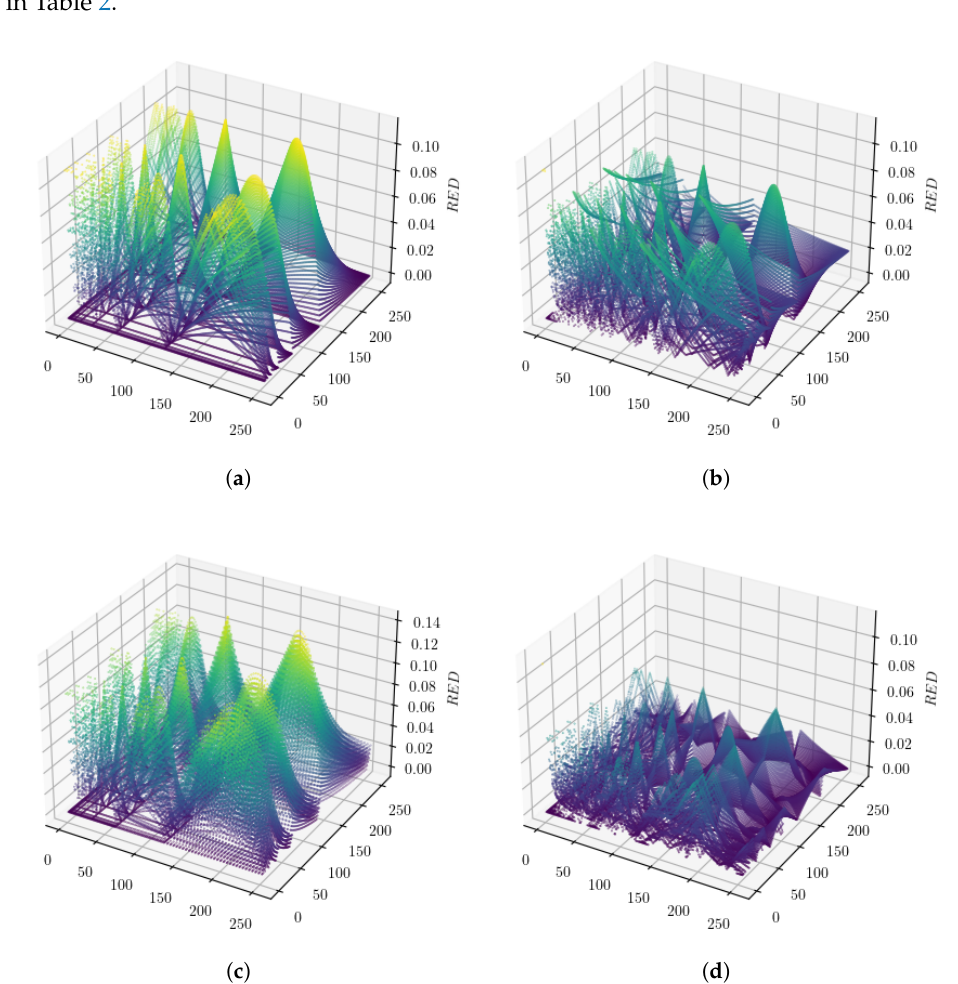
Figure 6. RED distribution comparison. ( a ) Original Mitchell multiplier RED distribution. ( b ) MBM RED distribution. ( c ) Mitchell-w6 multiplier RED distribution. ( d ) Pwl-Mit multiplier RED